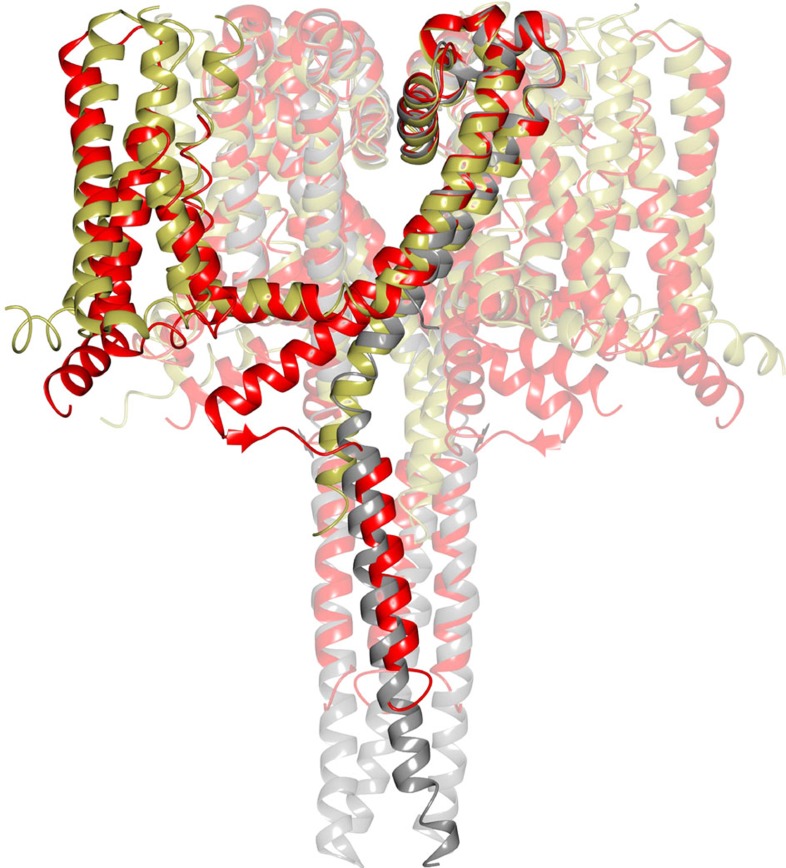
Structural alignments comparing the CTDs of open and closed sodium channels.Alignments of Nav structures that have all (NavMs (red) and NavAe1 (grey)) or part (NavAb-humanNav1.7DIV chimera (gold)) of their C-terminal domains visible in crystals, showing the different orientations and structures at the end of the S6 pores. Only the open pore NavMs structure shows the stabilising interactions with the S4–S5 linker. The overlap of the C-terminal coiled-coils is evident in NavMs and NavAe1 where the distal ends are visible. These structures are compatible with the opening/closing models previously suggested278.